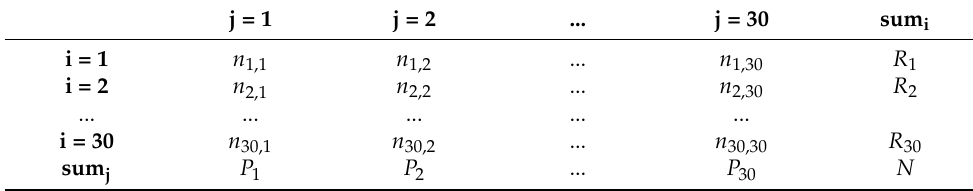
Table 3. Bins for calculating the Chi square. j =